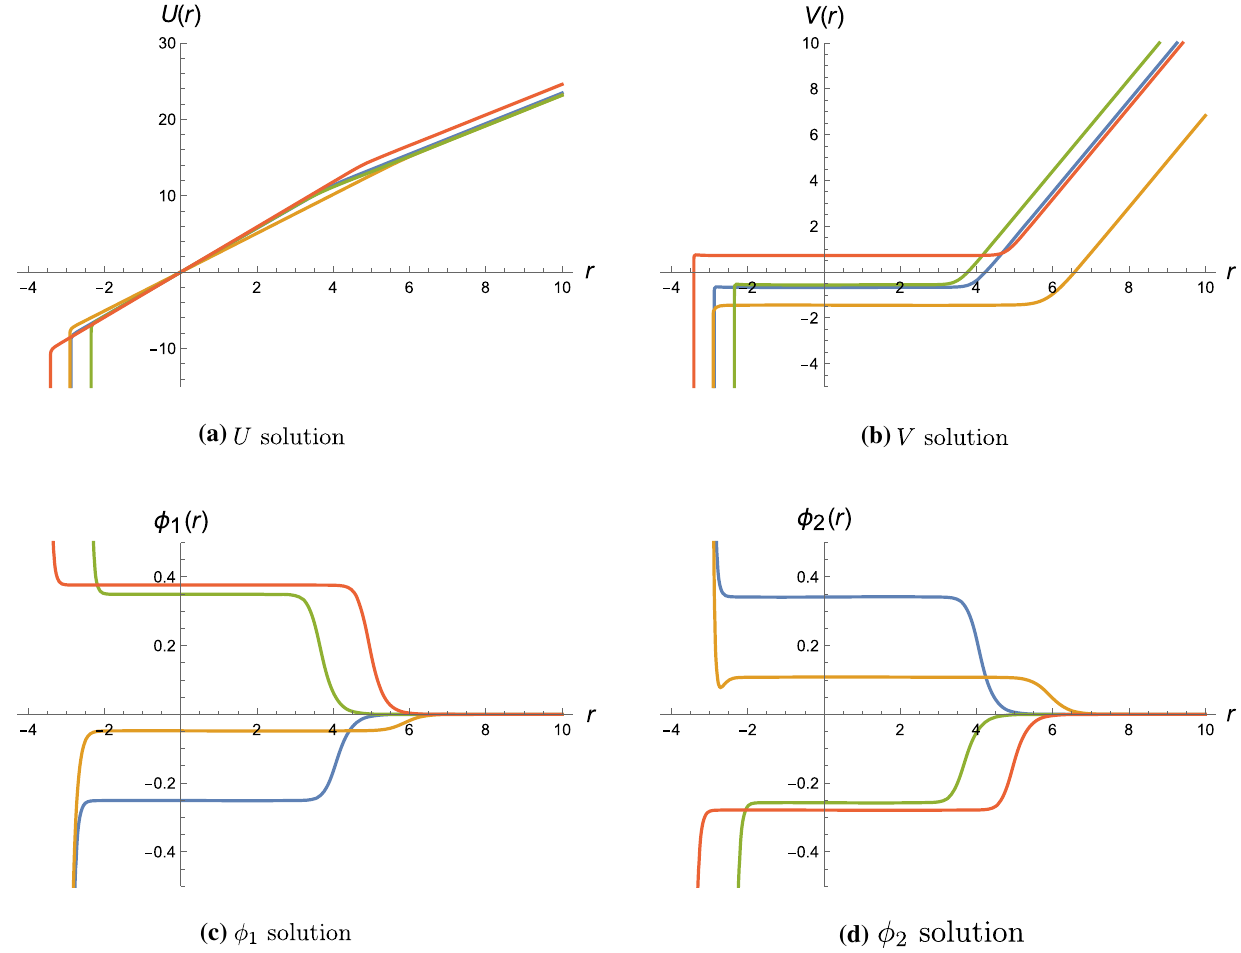
Fig. 1 RG flows from the N = 4 AdS 7 critical point as r → ∞ to AdS 5 × H 2 fixed points and curved domain walls for SO ( 2 ) × SO ( 2 ) twist in SO ( 5 ) gauge group. The blue, orange, green and red curves refer to p 2 = − 1